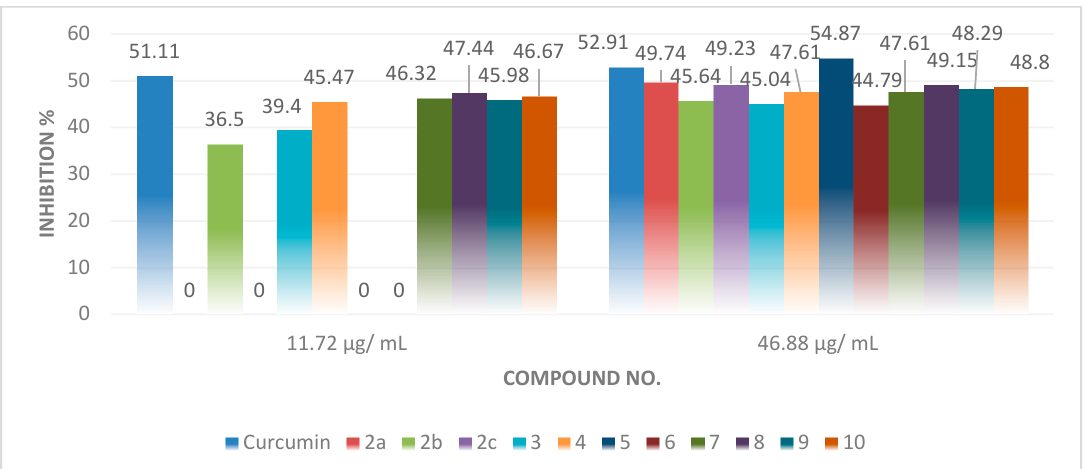
Figure 2. Comparison of the inhibition percentages of the tested compounds using a DPPH assay.